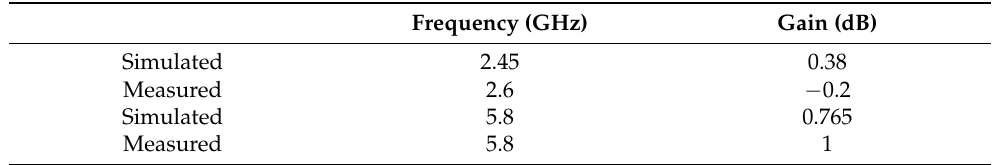
Table 4. Measured and simulated gain.